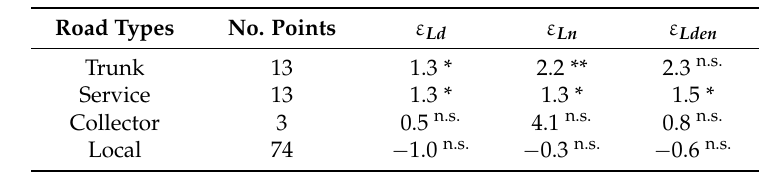
Table 4. Prediction errors ( ε ) of Ministry of Transport and Telecommunications road types for L d , L n and L den descriptors.